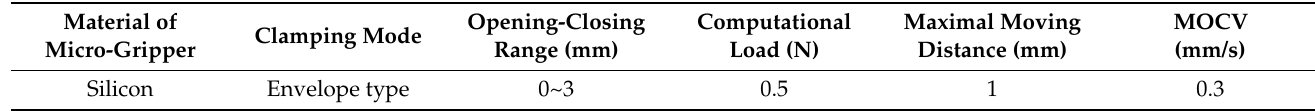
Table 2. Design parameters of micro-gripping